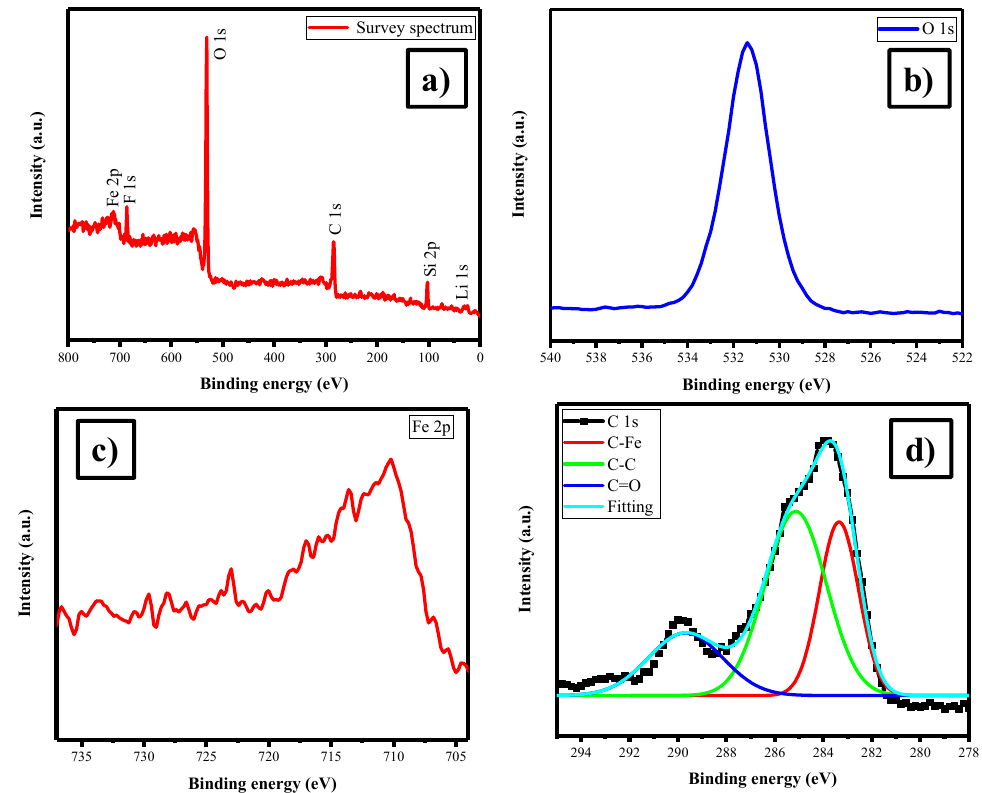
Figure 9. ( a ) Survey, ( b ) O 1s, ( c ) Fe 2p and ( d ) C 1s XPS spectra of Li 2 FeSiO 4 /C after the 100th cycle (post-mortem).